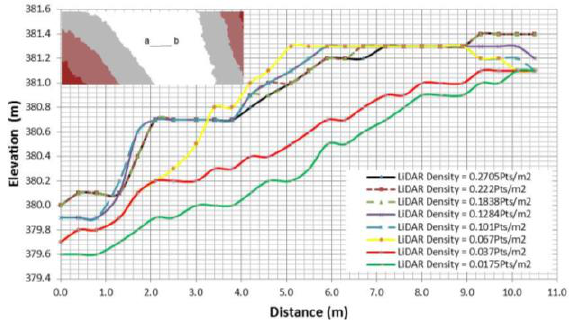
Figure 21. Profiles a-b extracted from DEMs created from LiDAR data of different point cloud densities.